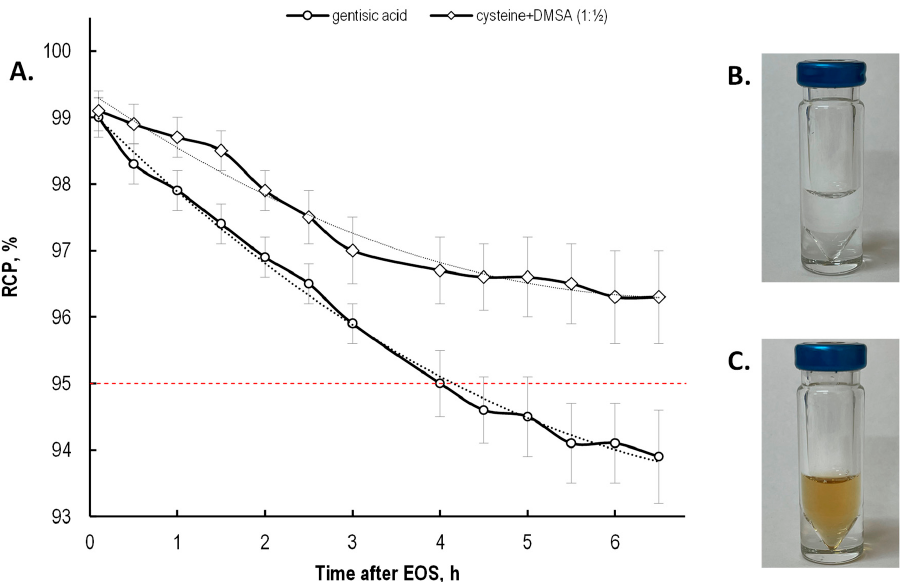
Figure 15. ( A ) Change in the radiochemical purity of [ 177 Lu]Lu-PSMA-617 preparations with 7.4 GBq of 177 Lu (samples volume—2 mL, pH 4.5, synthesis at 95 °C for 30 min, C(Na-acetate) = 0.15 mol/L, gentisic acid—5 mg (32 μ mol), cysteine—3.9 mg (32 μ mol); RCP value is presented as mean ± SD, n = 3); ( B ) Photograph of the 7.4 GBq [ 177 Lu]Lu-PSMA-617 sample prepared with cysteine 3.9 mg (32 μ mol) + DMSA 2.9 mg (16 μ mol) after 24 h of storage at RT; ( C ) Photograph of the 7.4 GBq [ 177 Lu]Lu- PSMA-617 sample prepared with 5 mg gentisic acid (32 μ mol) after 24 h of storage at RT. After 6.5 h of storage at room temperature, the ‘cysteine + DMSA’ sample showed a higher RCP than the ‘gentisic acid’ sample (96.3 ± 0.6% and 93.9 ± 0.7%, respectively; p <